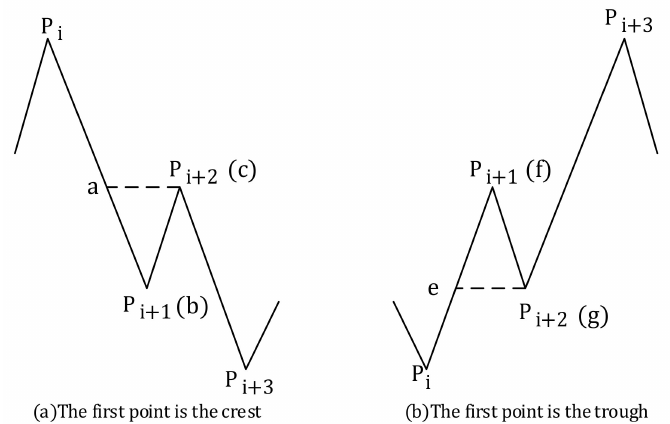
Figure 7. The counting principle of the four-points RFC